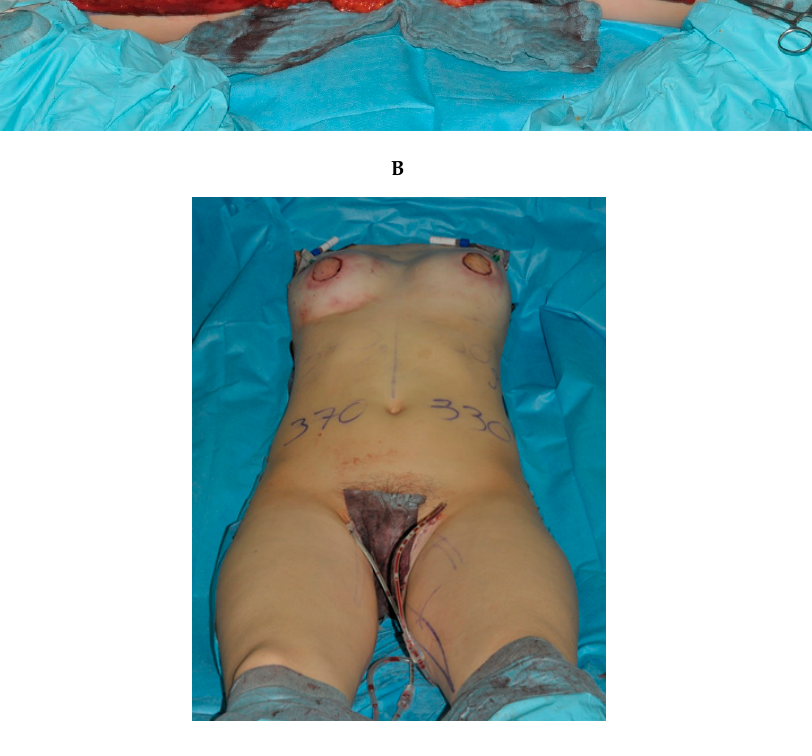
Table 1. Patient age and BMI of study groups. Table